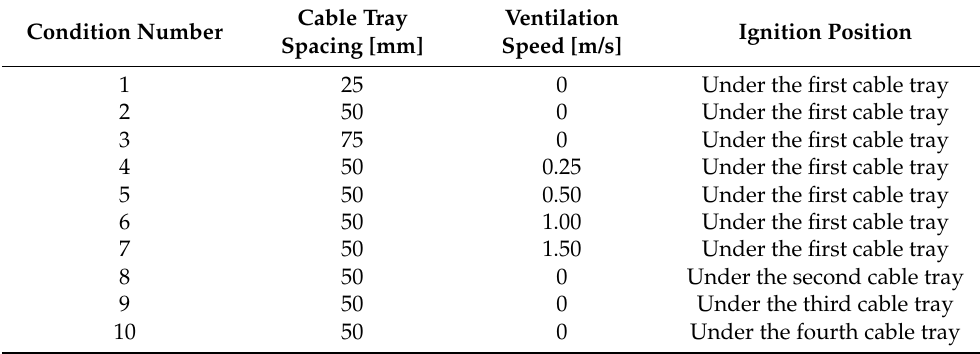
Table 3. Table of Simulated Operating